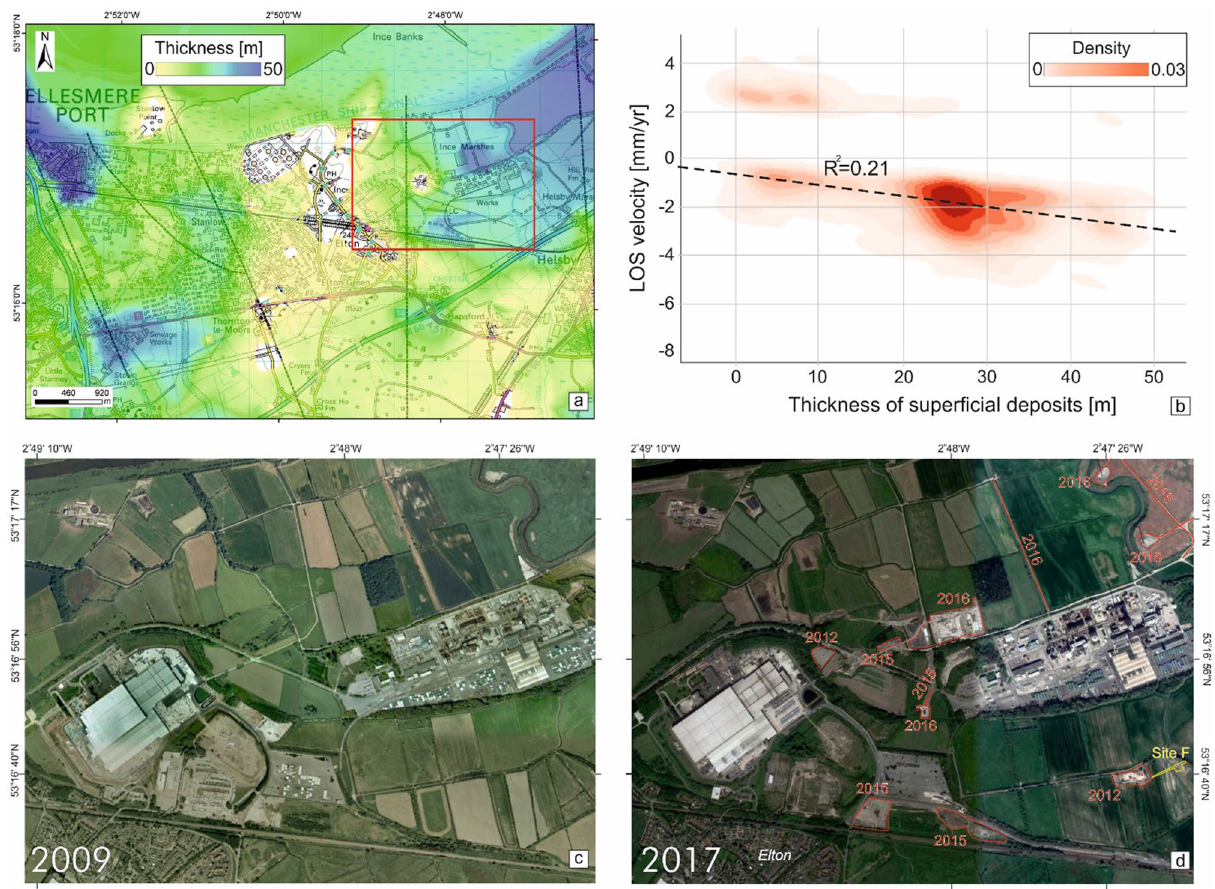
Figure 6. Correlation of ground motion with superficial deposit thickness and contruction activities. ( a ) thickness map of the superficial deposits. ( b ) kernel density estimate plot of the LOS velocity of the unstable targets with a linear pattern of motion identified in the ERS, ENVISAT and Sentinel-1 InSAR results. Major land cover changes observed between ( c ) December 2009 and ( d ) April 2017 within the studied area (red box in a ). Maps data: Google, 2021 Maxar Technologies, 2021 Infoterra Ltd & Bluesky Image and 2021 Getmapping plc.